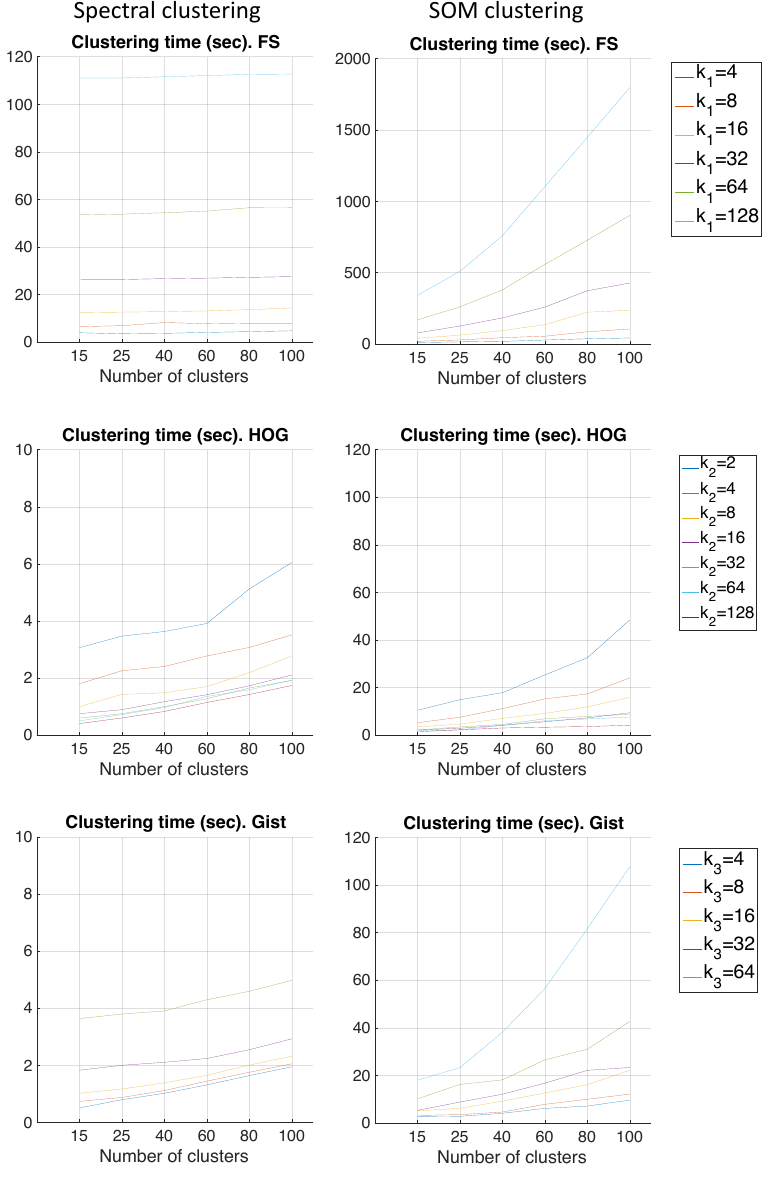
Figure 9. Results of the two clustering methods: computing time vs. number of clusters, when using FS, HOG, and gist descriptors in the Quorum V